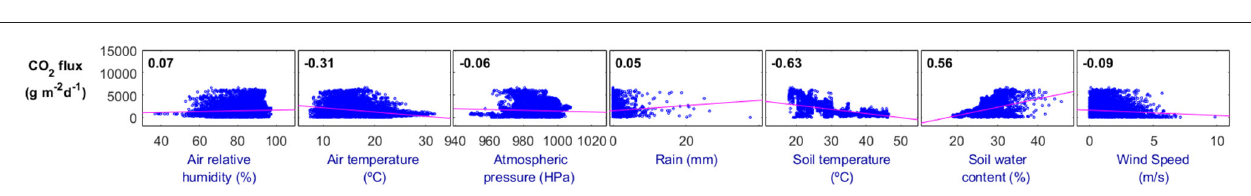
FIGURE 2 | Environmental and soil CO 2 flux time series for the period selected to build the regression model (2013–2014). Orange lines represent the soil CO 2 flux in all graphics, black line the rainfall (b) , and the blue lines the other monitored environmental variables, from (a–f) soil temperature, soil water content, air temperature, air relative humidity, atmospheric pressure and wind speed.